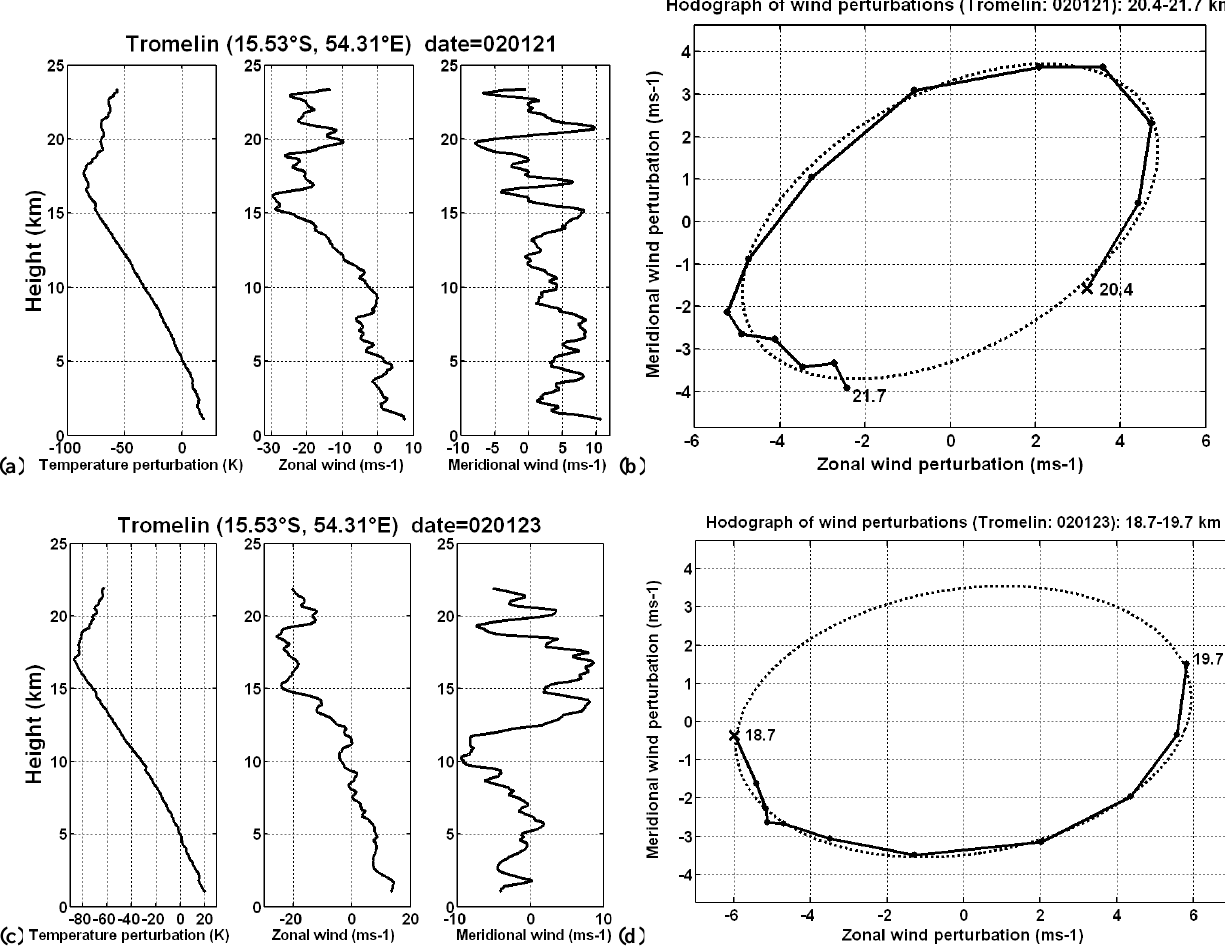
Fig. 3. Vertical profiles of temperature and horizontal winds on (a) 21 January, (c) 23 January 2002 and respective hodogaphs (solid line) with the fitting ellipse (dotted line) of horizontal wind perturbations in the lower stratosphere (b) and (d) at Tromelin. x and points indicate the starting point of the hodograph and each 100-m height,